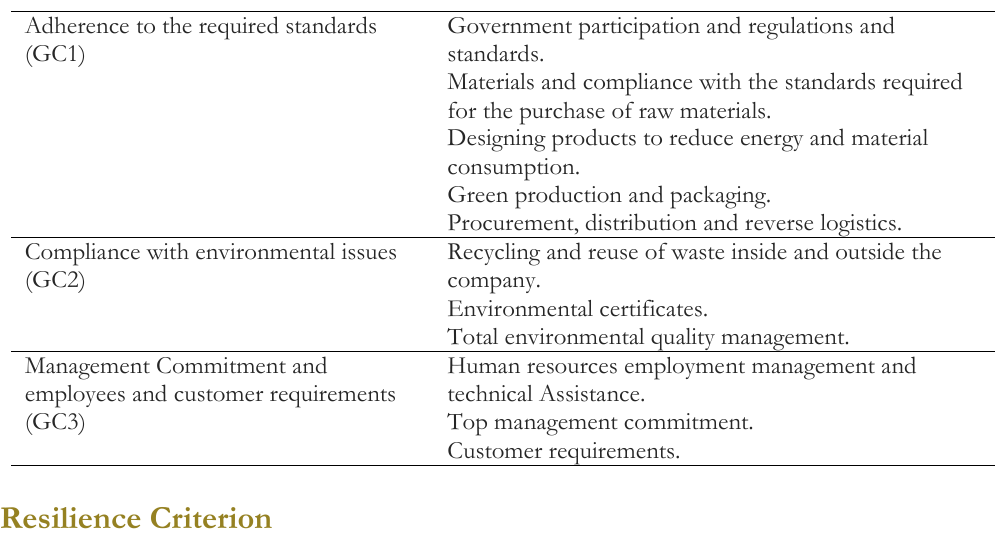
Table 1. Key green criteria in evaluating suppliers’